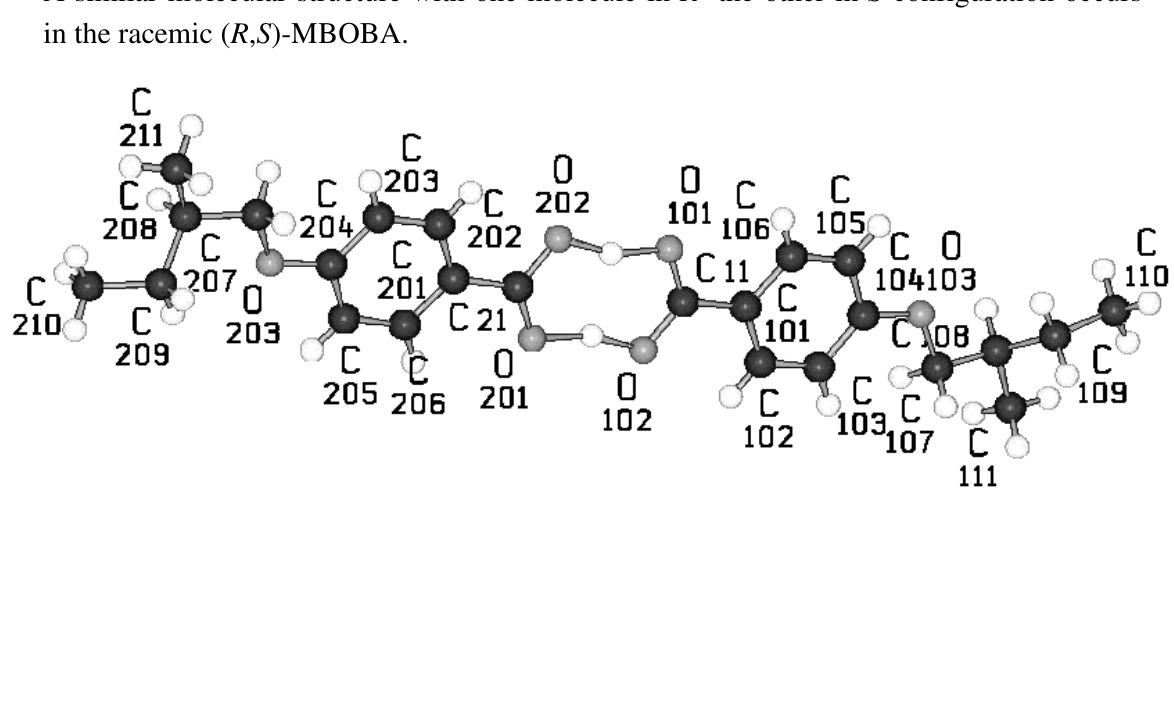
Figure 8. Representation of the conformations and atom numbering of S